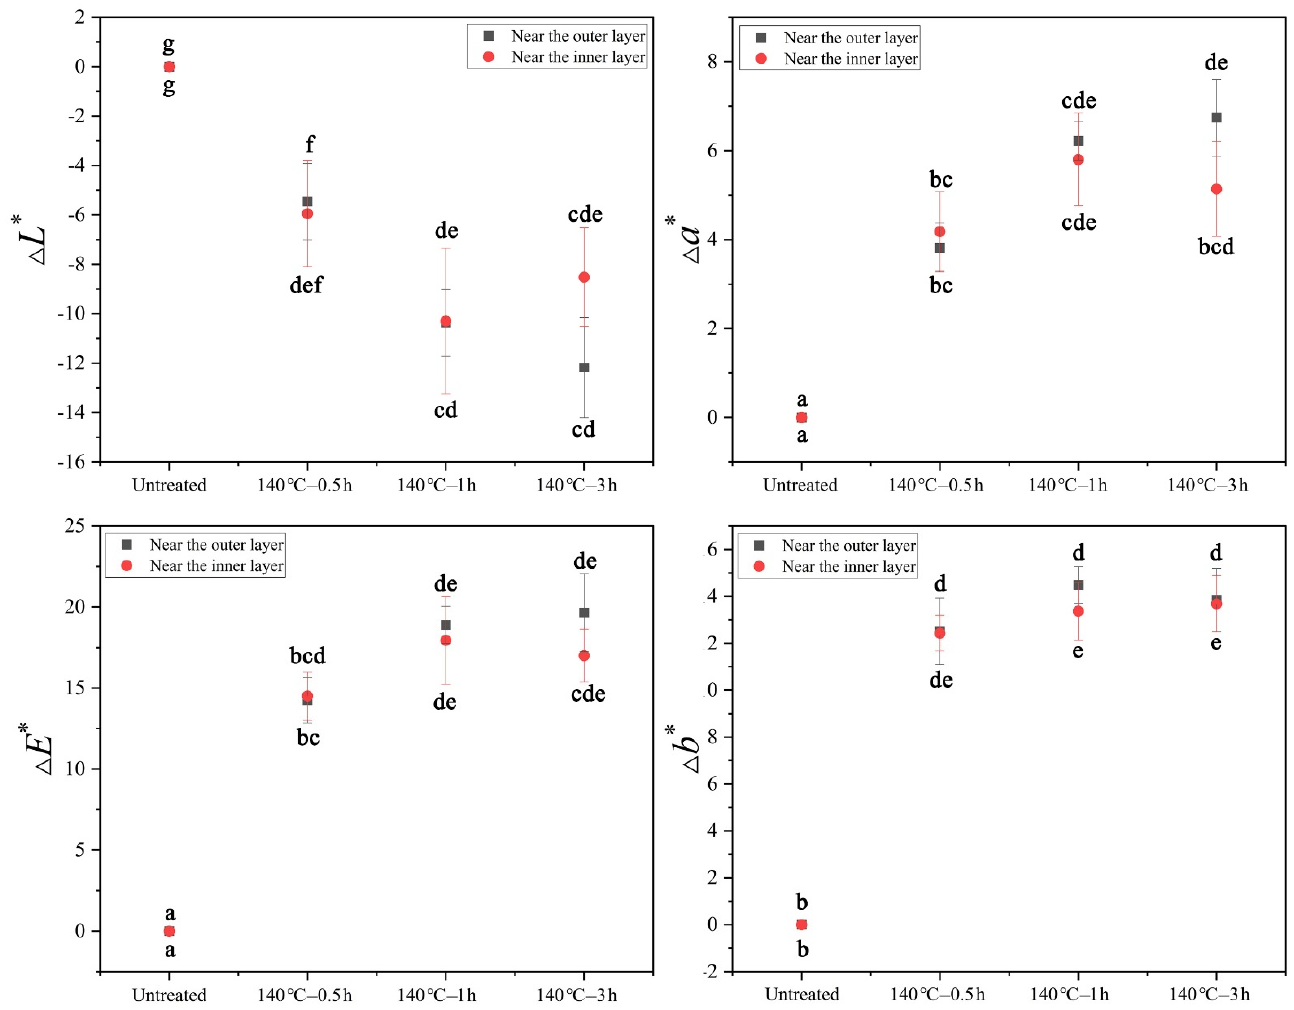
Figure 3. The variation in bamboo color after tung oil treatment at 140 °C for 0–3 h. (* Note: Mean values followed by the same superscript letters (a, b, c, d, e, f or g) in the same column are not significantly different at <0.05. Values in parentheses are standard deviations. Outer: the surface near the outer layer of bamboo. Inner: the surface near the inner layer of bamboo.).